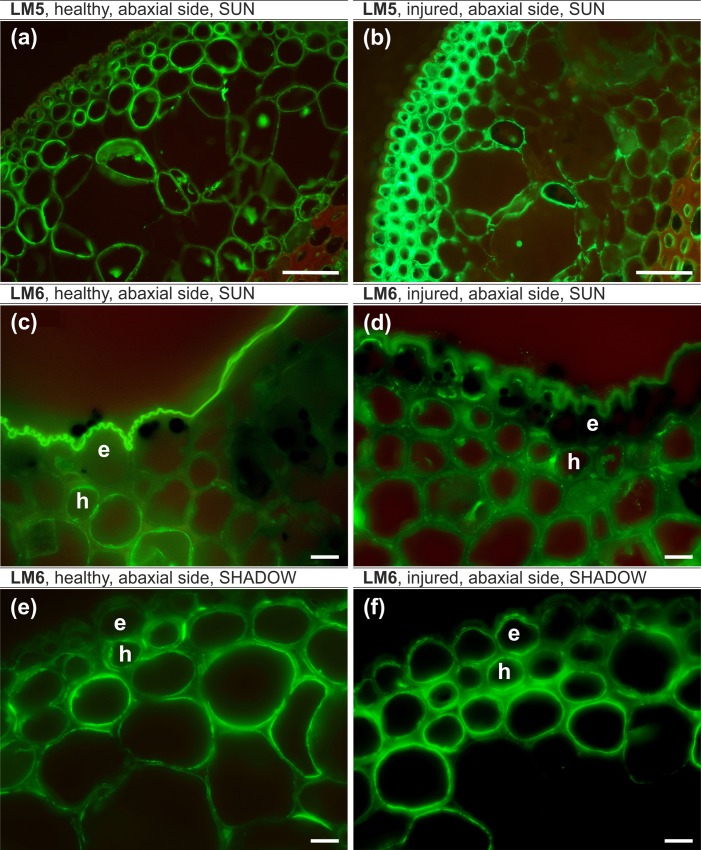
LM5 epitope, leaf lamina, sunlit side (a,b), LM6 epitope, leaf lamina, sunlit side (c,d) LM6 epitope, leaf lamina, shady side (e,f). (a,c,e) – healthy leaf, (b,d,f) – injured leaf, (a-f) – abaxial side. e – epidermal cells, h – hypodermal cells. Bars, 10 μm.